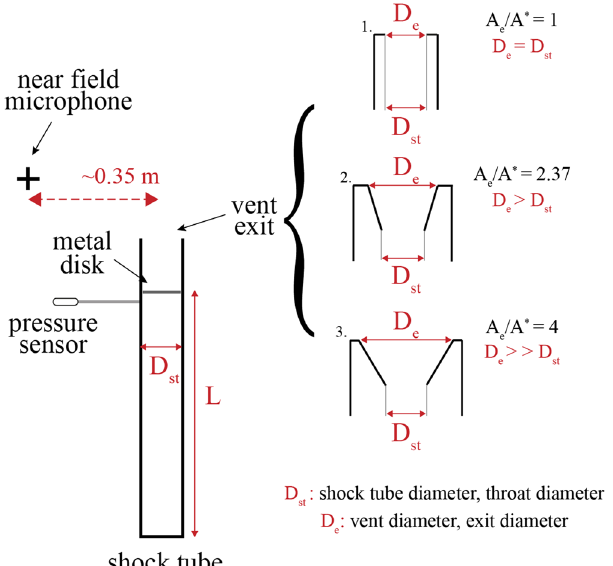
Figure 2. Setup configuration. Shock tube with a constant diameter D st and variable length L. Three shock-tube exit geometries were studied as represented: (1) straight, (2) slightly divergent and (3) strongly divergent. The microphone was located at a similar height to the shock-tube exit at a distance of 12.5 D at an angle of 2.29°. In the setup used, D st also represents the throat diameter, the smallest diameter the flow as to pass through. D e is the exit diameter and it also represents the vent diameter.